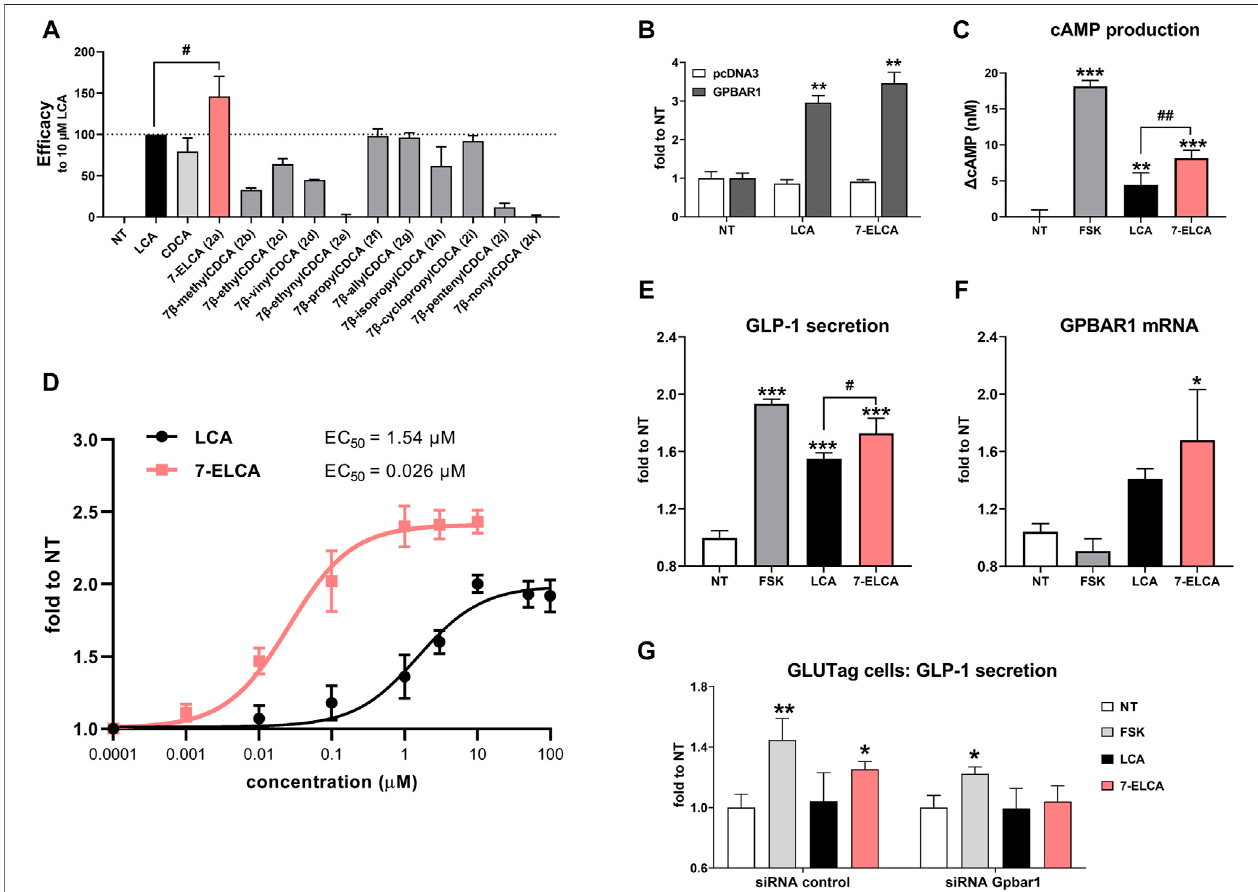
FIGURE 8 | Effects of 7-alkylated derivatives of CDCA and 7-ELCA on the membrane receptor GPBAR1. (A, B, D) HepG2 cells were co-transfected with a CRE- containing luciferase reporter plasmid and a GPBAR1 expression vector and cells were then treated with tested compounds at 10 µM ( A,B ) or with increasing concentrations (D) for 5 h. (A) Ef fi cacy of tested compounds to activate CRE-luc was compared to the activity of 10 µM LCA (set as 100% activation). (B) CRE-luc activationdependsonthepresenceofGPBAR1. (C) EffectsofLCAand7-ELCA(bothat10 µM)onintracellulargenerationofcAMPindifferentiatedNCI-H716cells after 30 min treatment. The increase in cAMP level ( Δ cAMP) is presented as the difference between cAMP concertation in the treated sample after subtraction of the cAMPinthenontreated controlsample. (D) Concentration-responsecurvesforactivationofGPBAR1 byLCAand7-ELCA.EC 50 valueswerecalculatedusingnonlinear fi tting of concentration-response curves. (E) 7-ELCA and LCA (both 10 µM) stimulate GLP-1 secretion and (F) GPBAR1 mRNA expression in differentiated human enteroendocrineNCI-H716cellsafter2 htreatment. (G) 7-ELCA(10 µM)increasesGLP-1secretioninsiRNAcontrolbutnotinsiRNA Gpbar1transfected GLUTagcells after 1 h treatment. GLP-1 was normalized to protein concentration and GPBAR1 mRNA expression to GAPDH mRNA. Data are presented as a fold to control nontreated (NT) samples. Forskolin (FSK, 10 µM) was used as a GPBAR1-independent activator of cAMP production. Values are presented as means ± SD from three independent experiments performed in triplicates. ** p < 0.01, *** p < 0.001 vs. NT; # p < 0.05, ## p < 0.01 vs. 10 µM